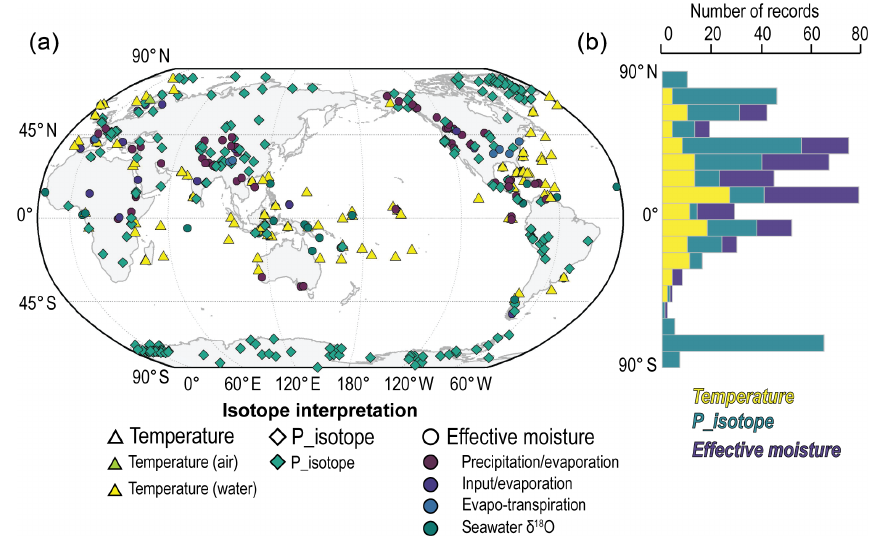
Figure 4. (a) Map of records in the Iso2k database with colors representing the first-order “isotope interpretation” metadata field for each record (primary time series only; see Sect. 2.4). Symbols correspond to the three isotope interpretation “super-groupings” (see Sects. 4.3 and 5.1). (b) Bar chart showing the latitudinal distribution of records in the Iso2k database. Each bar represents 10 ◦ of